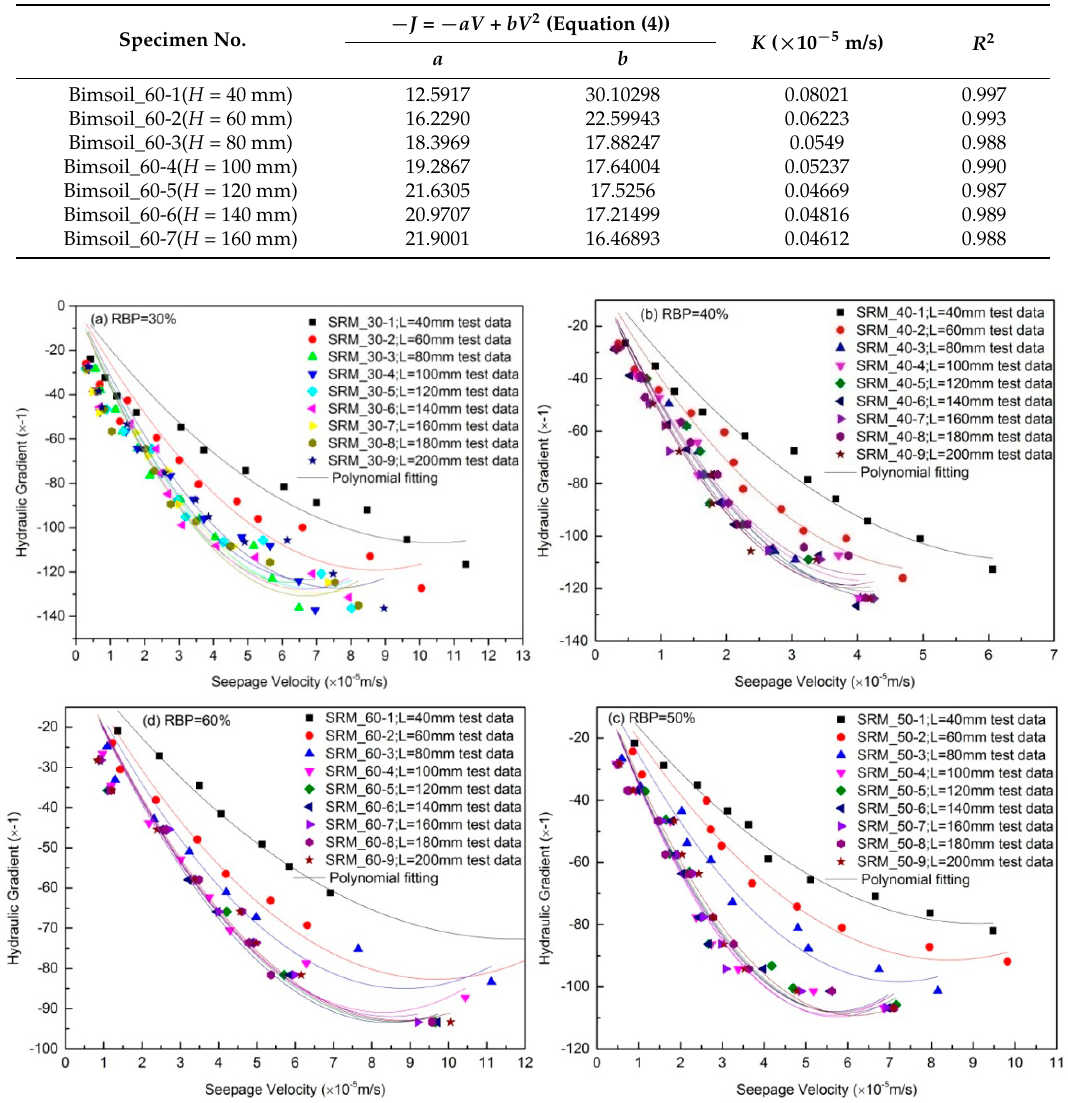
Table 6. The non-Darcy’s flow equations for typical specimens with rock block percentage of 60%, using Forchheimer equation.